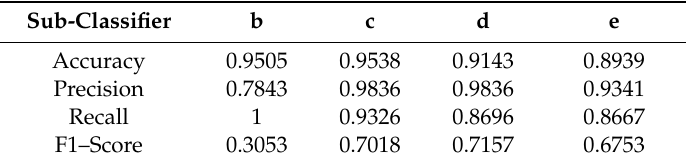
Table 8. Performance of each sub-classifier.